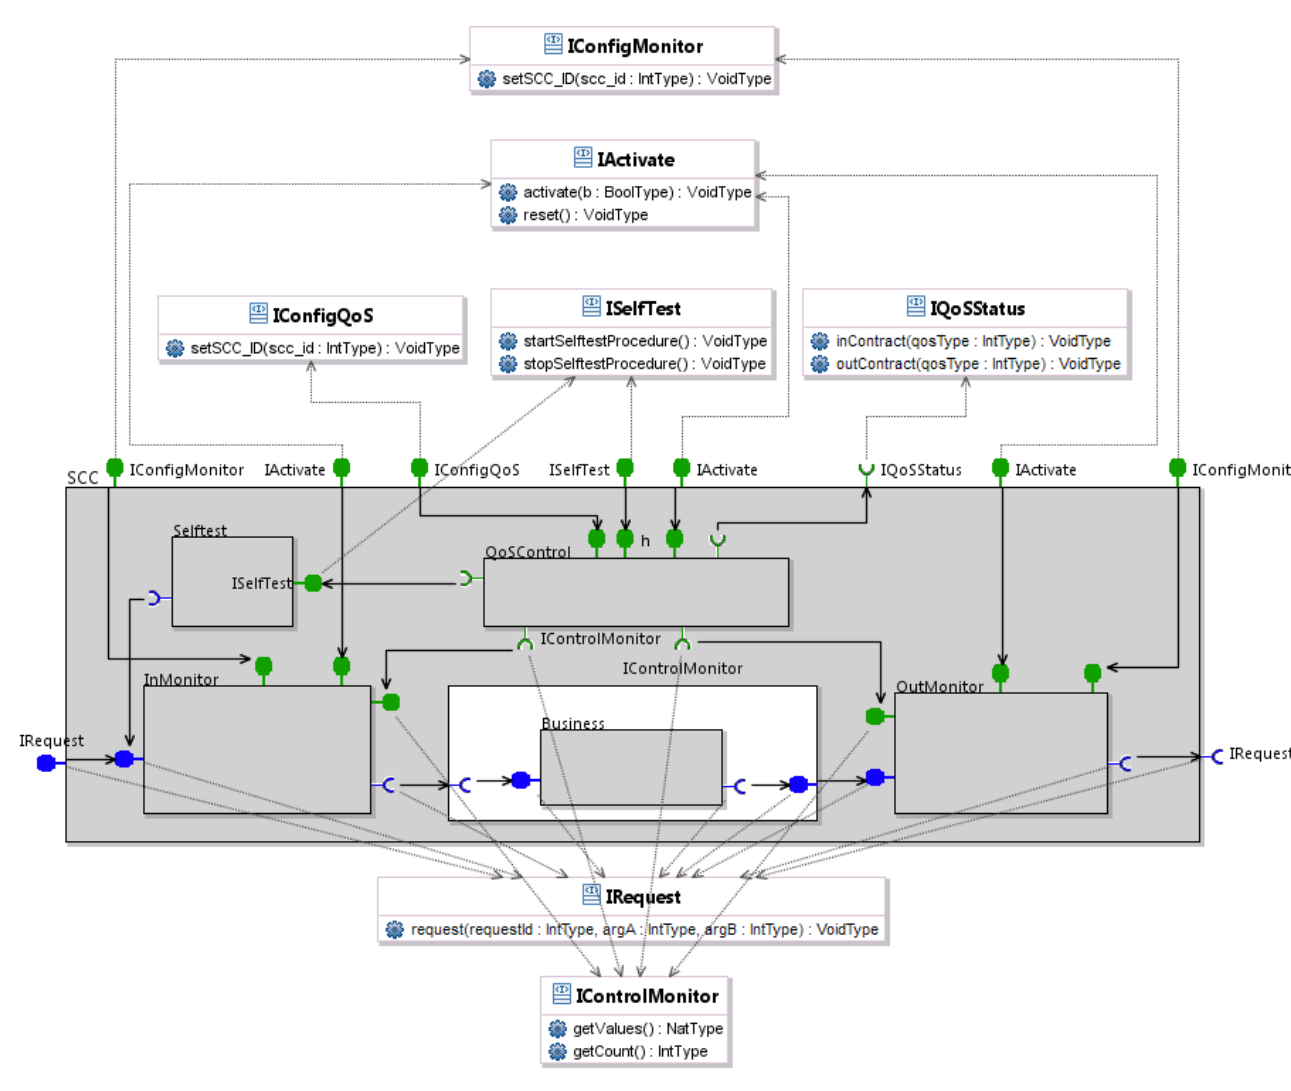
Figure 2. Self-test SCC